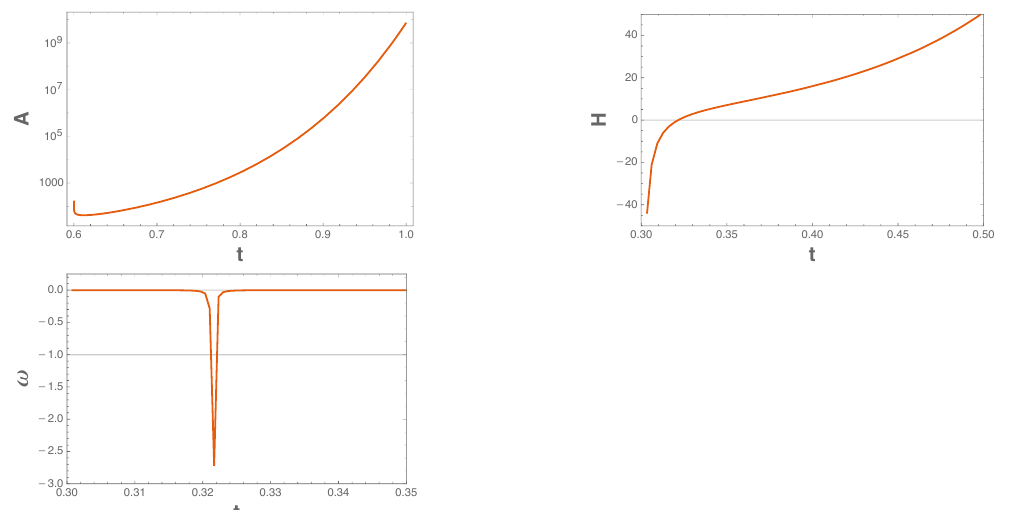
( t ) . We use arbitrary units, namely, √ 1 φ 2